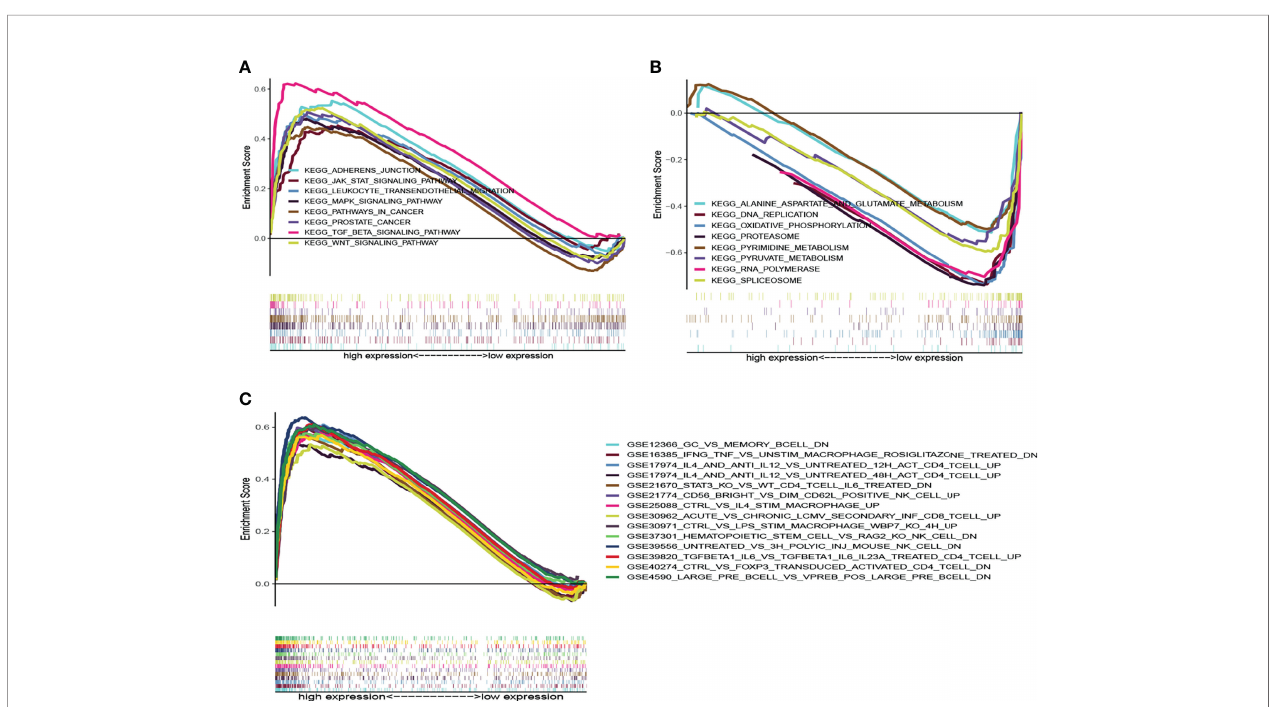
FIGURE 5 | GSEA for samples with high-DLC1 and low-DLC1 expression. (A) Enriched gene sets in the KEGG collection of the high-DLC1 expression sample. Each line is uniquely colored demonstrating one particular gene set. Upregulated genes are located on the left approaching the origin of the coordinates, while the downregulated ones lay on the right of the x -axis. Only gene sets satis fi ed with NOM P < 0.05 and FDR q < 0.07 were considered signi fi cant. In the plot, only leading gene sets are presented. (B) Enriched gene sets in the KEGG collection of low-DLC1 expression sample. (C) Enriched gene sets in C7 collection and the immunologic gene sets in the high-DLC1 expression sample. Only leading gene sets are displayed in the plot.